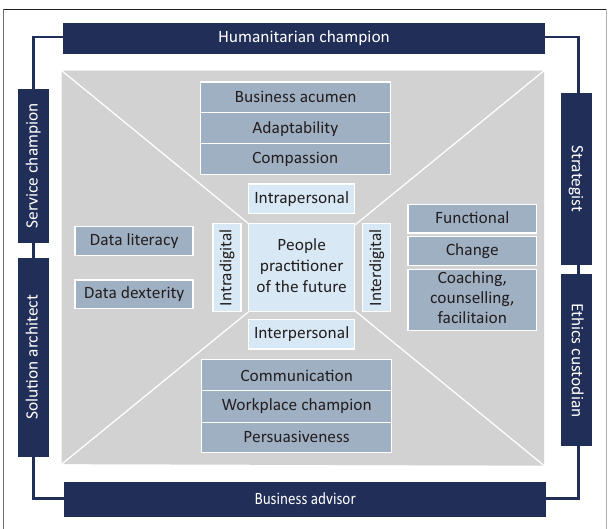
FIGURE 2: Integrative conceptual model of the future-fit people practitioner professional personas and